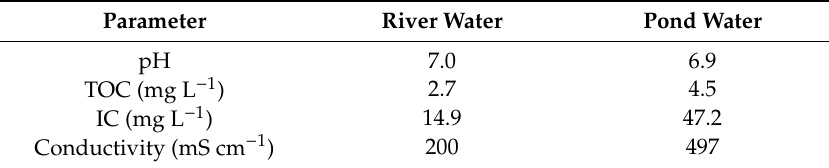
Table 1. Representative analysis of the real water matrices tested in this work.